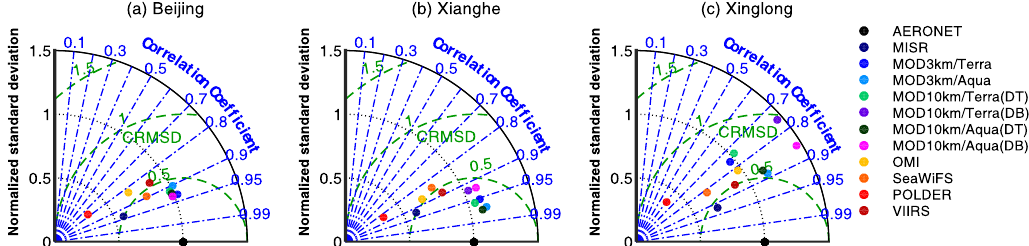
Figure 3. Pattern statistics of Taylor diagrams comparing satellite retrievals and AERONET observations in terms of monthly mean AODs at the ( a ) Beijing, ( b ) Xianghe, and ( c ) Xinglong sites.